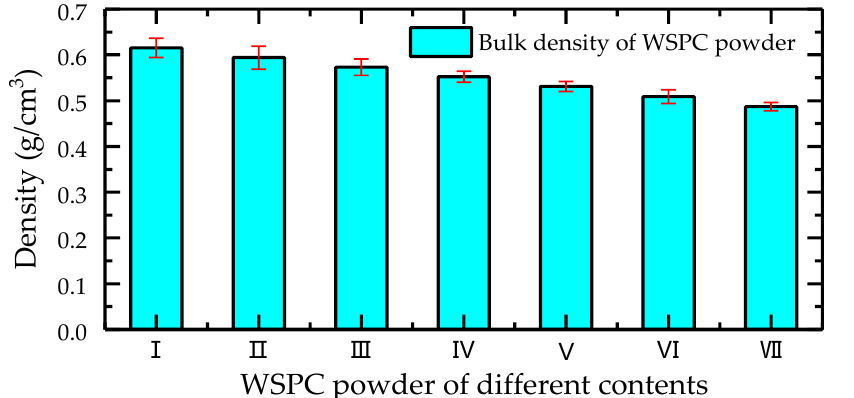
Figure 10. The bar graph of density changes of WSPC parts.